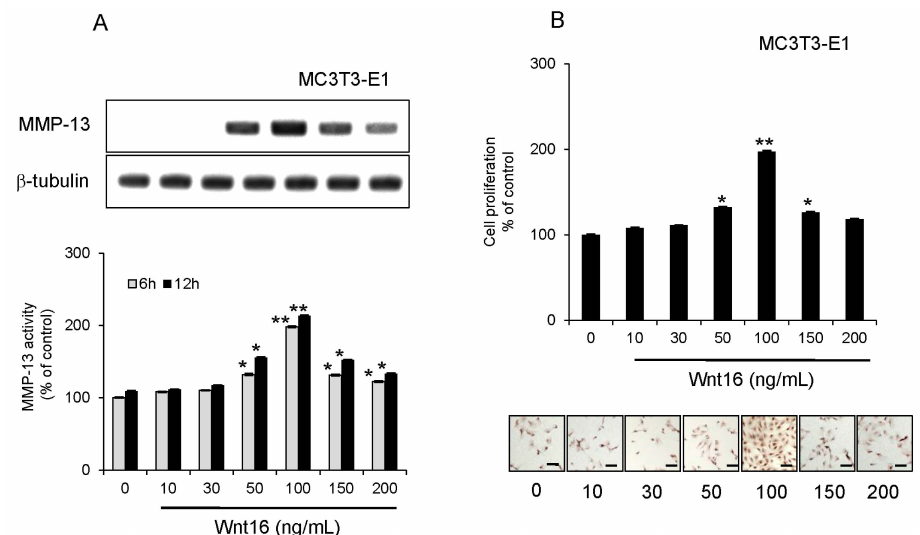
Figure 4. Effect of exogenous Wnt16 on MMP-13 expression and activity, and the proliferation of MC3T3-E1 cells. ( A ) Cells were treated for 6 h (grey bars) and 12 h (black bars) with 0, 10, 30, 50, 100, 150 and 200 ng/mL exogenous Wnt16 prior to analysis. Upper panels show Western blots of MMP-13 protein expression compared with β -tubulin levels. Blots are representative of three independent experiments. Lower panels show MMP-13 activity. Data are the mean ˘ SD of four independent experiments. * p < 0.05, ** p < 0.01; ( B ) Effect of exogenous Wnt16 on cell proliferation. Cells were treated with Wnt16 (0, 10, 30, 50, 100, 150 and 200 ng/mL) for 24 h. Their proliferation status was then evaluated using the BrdU-cell proliferation ELISA (graphs) and BrdU immunohistochemistry kit (images; nuclei are stained brown in proliferating cells). Scale bars = 100 µ m. ELISA data are the mean ˘ SD of four independent experiments. * p < 0.05, ** p <